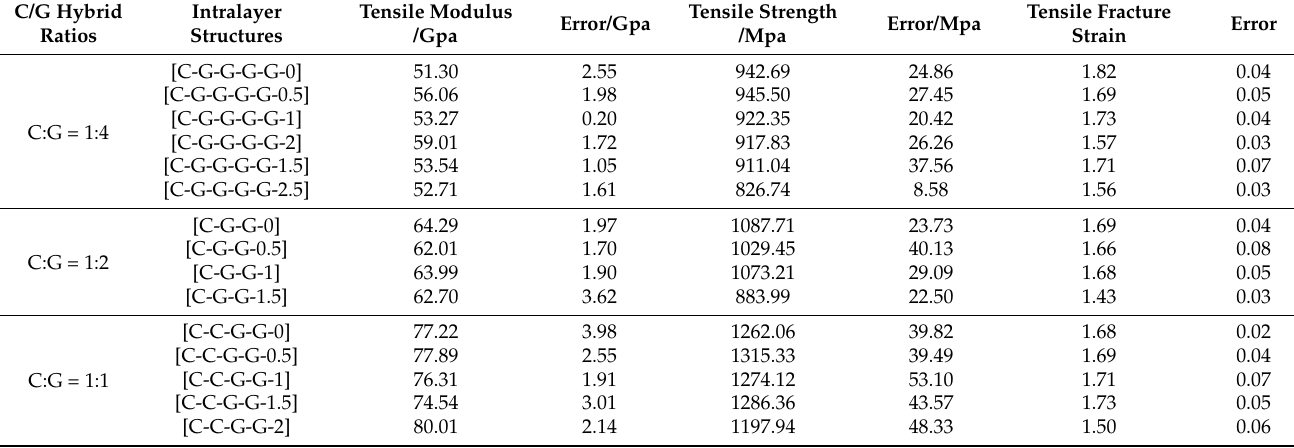
Table 7. The testing results of intralayer hybrid composites.